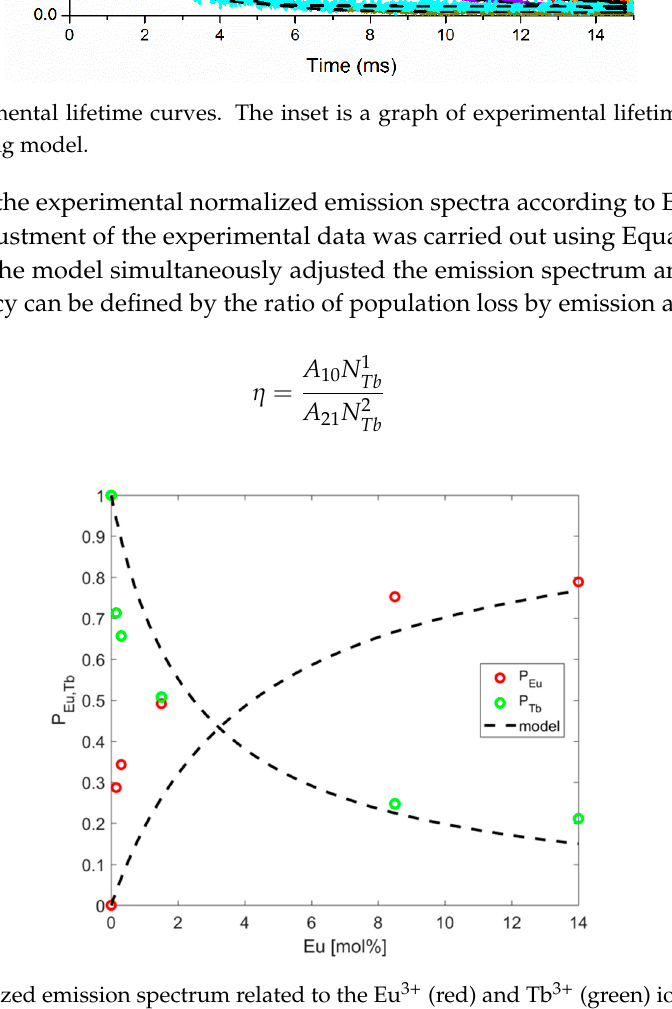
Figure 8. Normalized emission spectrum related to the Eu 3+ (red) and Tb 3+ (green) ions. Black lines represent the fitting model.